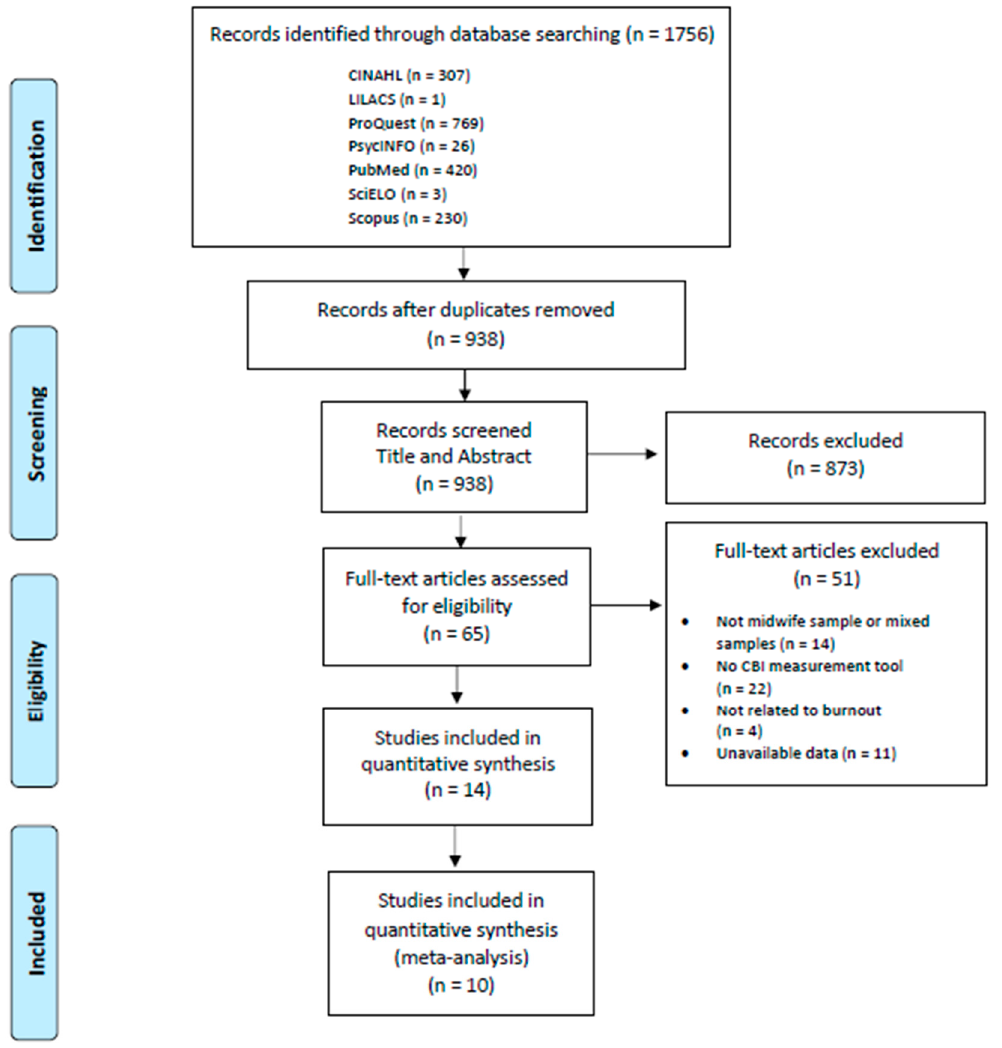
Figure 1. Flow diagram of the selection process.